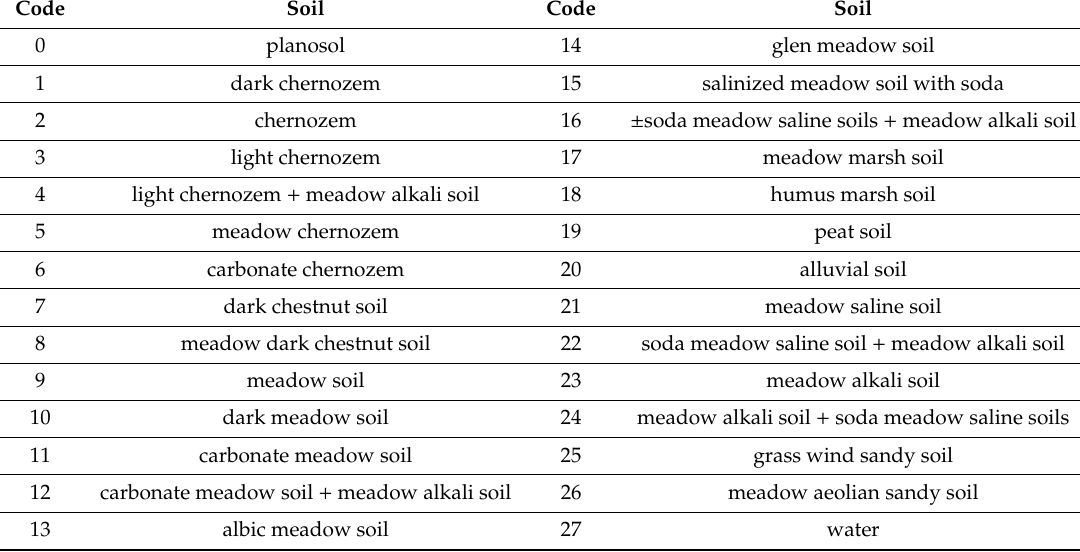
Table A2. Type of